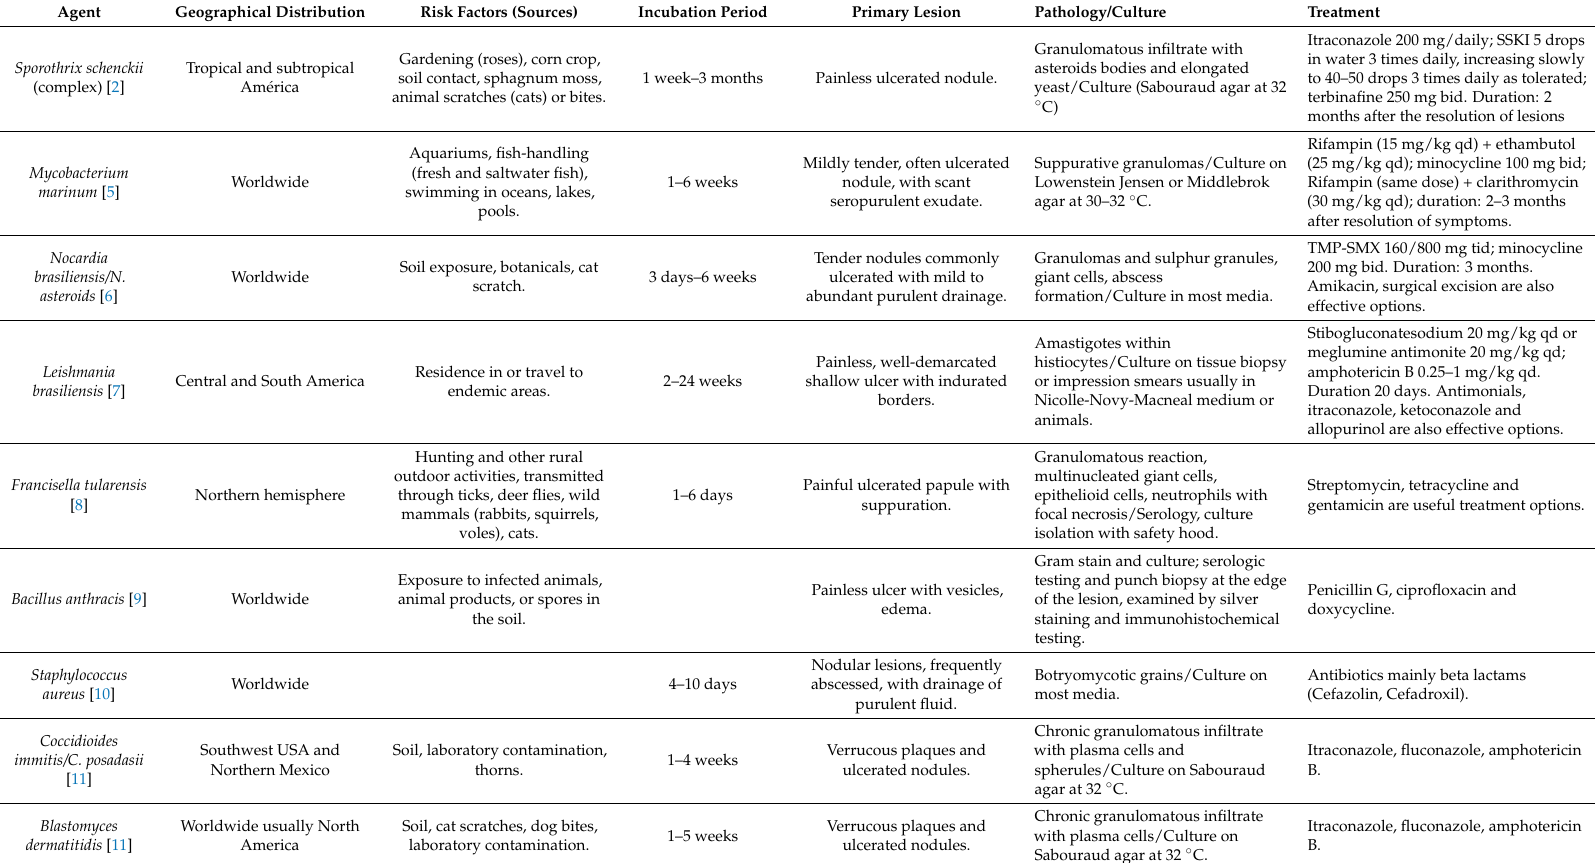
Table 2. Characteristics of the main causes of nodular